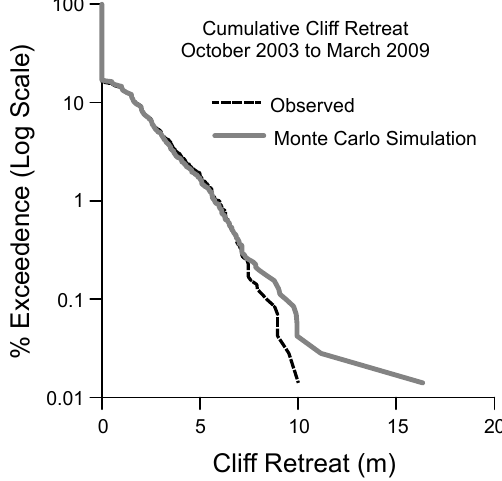
Fig. 12. Observed and Monte Carlo simulation (100realizations) of % exceedence of cumulative transect cliff retreat. The most common cumulative retreat is zero. The observed and modeled cumulative retreat distributions differ for large, infrequent events, but the distributions are overall only marginally different (k-s test, p = 0 . 21).